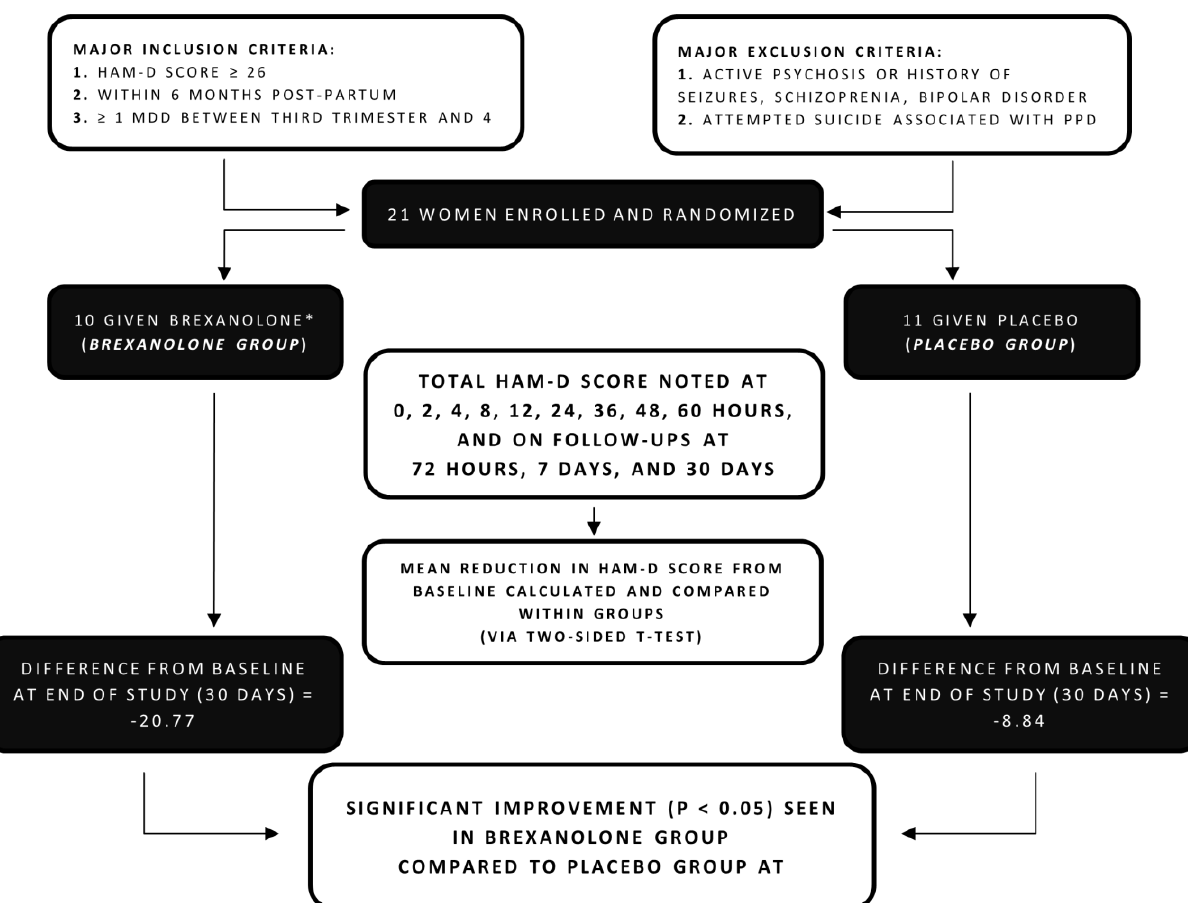
Figure 1. Flowchart summarizing methods and findings of randomized controlled trial by Kanes et al. 2017 [21].